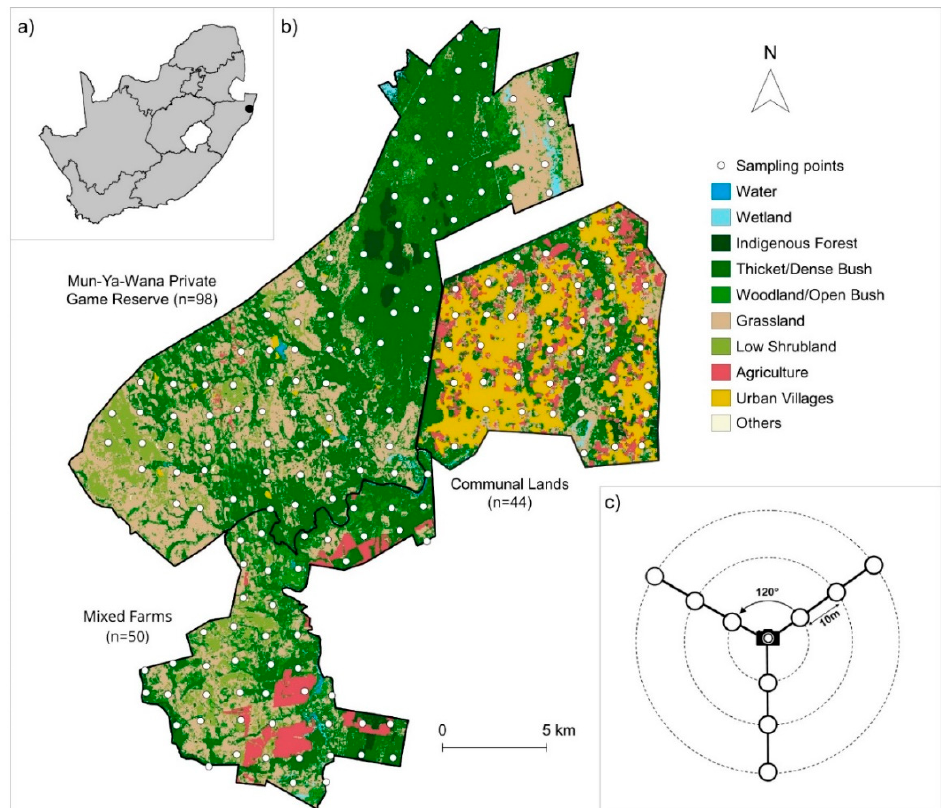
Figure 1. Location of the study area in South Africa, with the black dot representing the location of the study area in the Maputaland region of northern KwaZulu-Natal ( a ); landscape composition of the three studied areas with distinct management schemes–Mun-ya-wana private game reserve, mixed farms and communal land (Zulu tribal land)–with the location of the sampling points and the number of sampling points per area (in parenthesis) ( b ); each sampling point included a camera trap in the center and nine ink tunnels, distributed in a Y shape (open circles represent ink tunnels) ( c